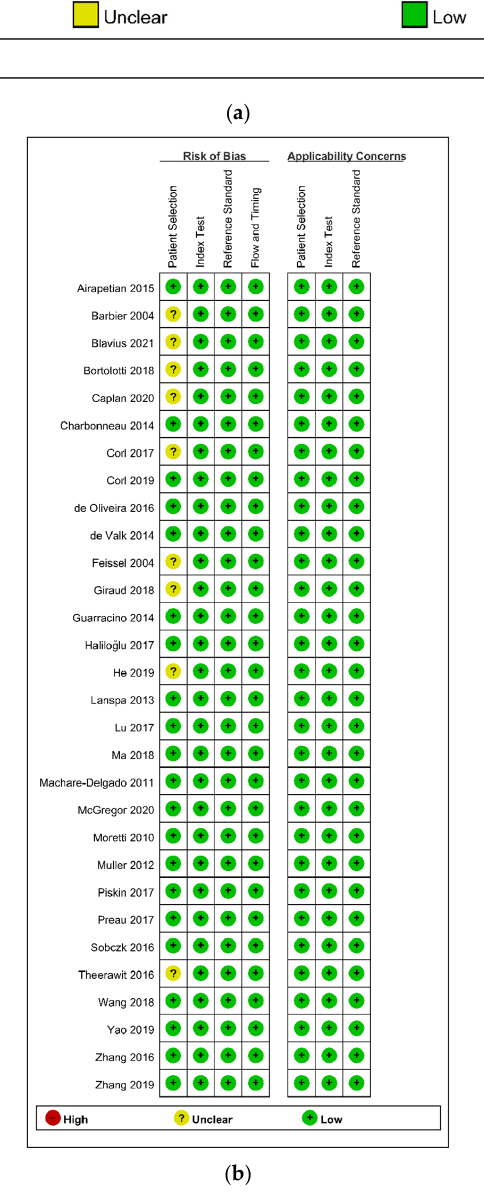
Figure 6. Risk of bias and applicability concerns graph ( a ) and summary ( b ): review authors’ judgements about each domain presented as percentages across included studies.